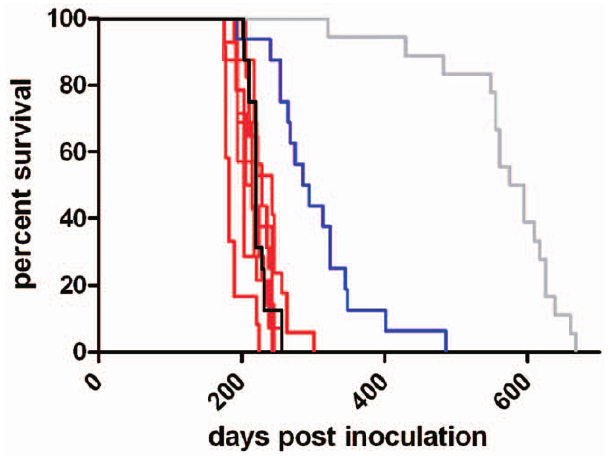
Figure 1. Survival of tg338 mice inoculated with different TSE isolates . Mice infected with Swiss atypical scrapie isolates (red) showed survival times similar to those infected with Nor98 (black), but these survival times were clearly shorter compared to the classical scrapie group (blue) and sham-inoculated mice (grey).